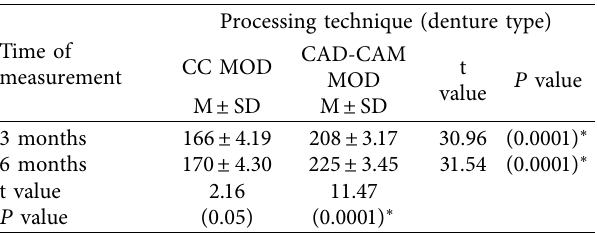
Table 2: Descriptive analysis of maximum biting force (MBF) values and P values of conventional PMMA and CAD/CAM PMMA im- plant overdenture prostheses along the various follow-up periods.